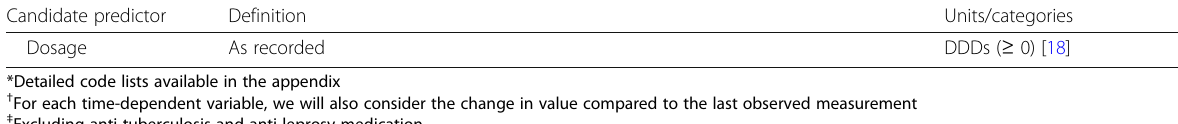
Table 1 Candidate predictors of bacteriuria measured (a) once at admission (constant throughout one hospital stay; time independent) and (b) multiple times throughout a patient ’ s hospital stay (time-dependent)